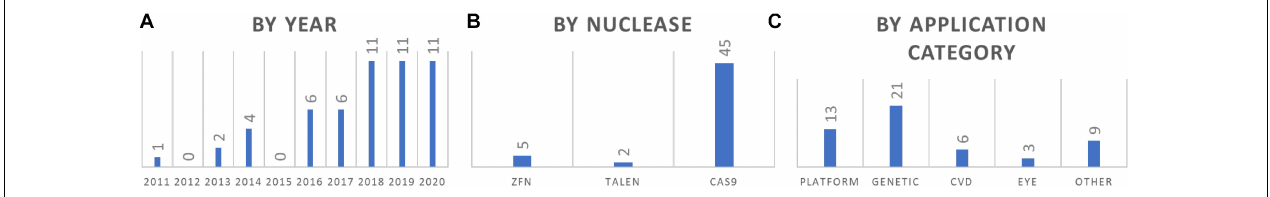
FIGURE 2 | Summary of GE rabbit publications. (A) Summary of reports by year. (B) Summary of reports by nuclease that was used. (C) Summary by application categories of the models.